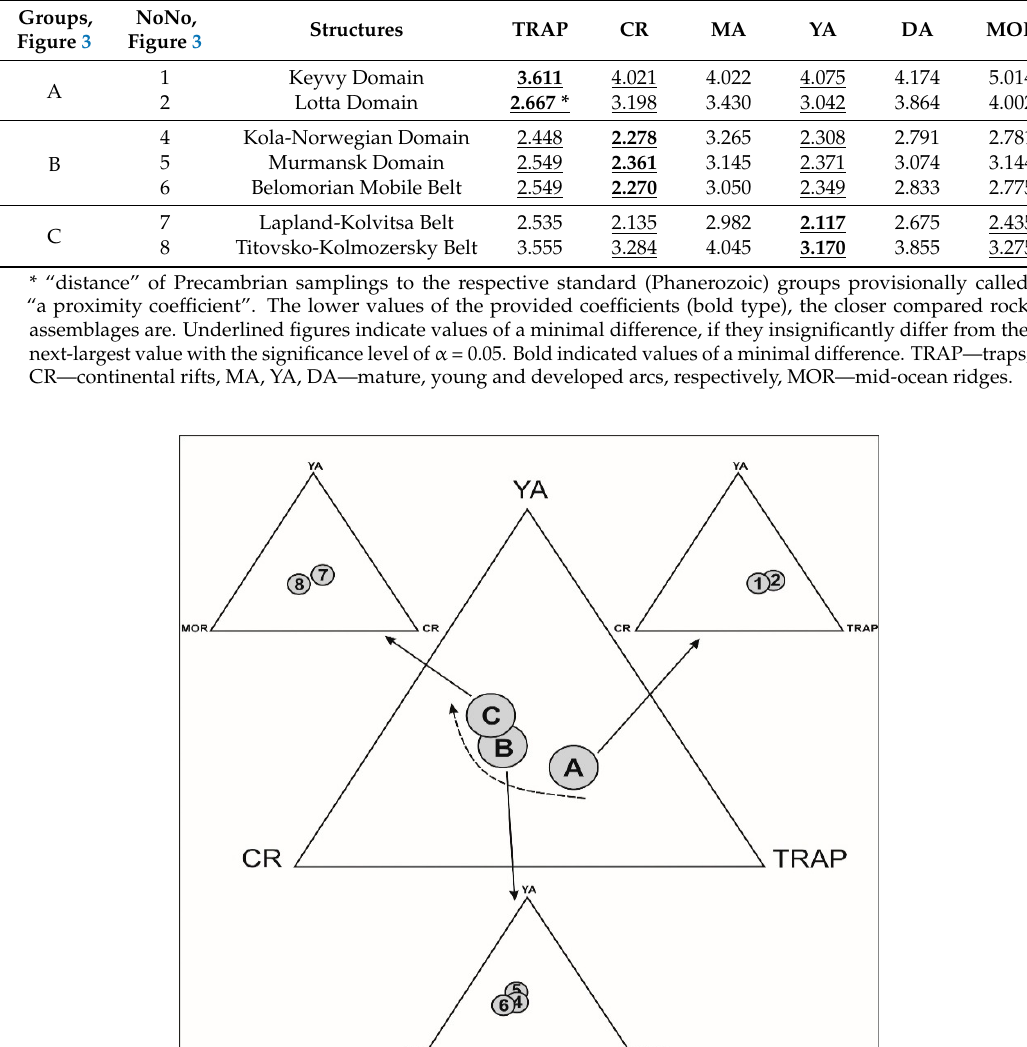
Table 1. Reconstructed formation settings of some Precambrian complexes.